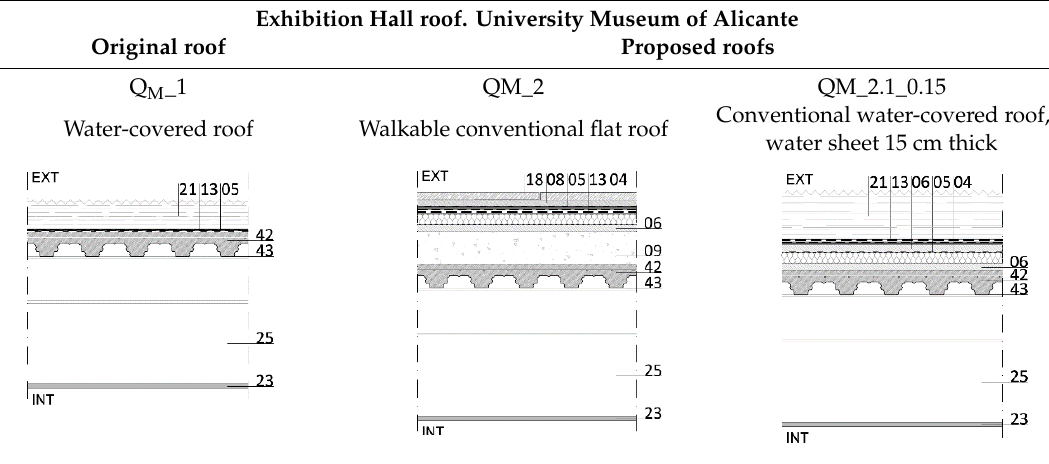
Table 6. Construction section of the MUA’s water-covered roof and its derivations.